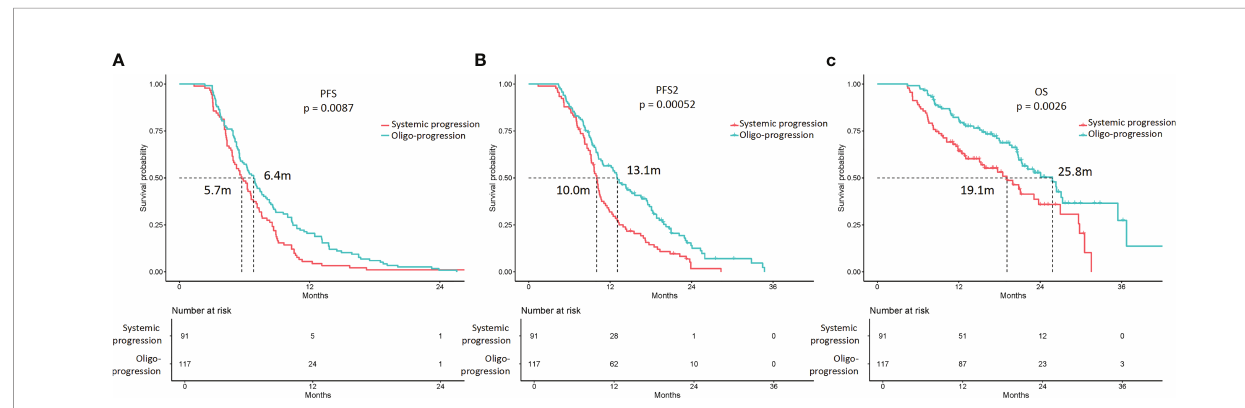
FIGURE 3 | Kaplan-Meier curves of the PFS, PFS2, and overall survival (OS) of patients with oligoprogression and systemic progression. (A) The mPFS were 6.4 and 5.7 months in patients with oligoprogression and systemic progression, respectively ( p = 0.009). (B) The mPFS2 were 13.1 and 10.0 months in patients with oligoprogression and systemic progression, respectively ( p = 0.001). (C) The mOS were 25.8 and 19.1 months in patients with oligoprogression and systemic progression, respectively ( p = 0.003).